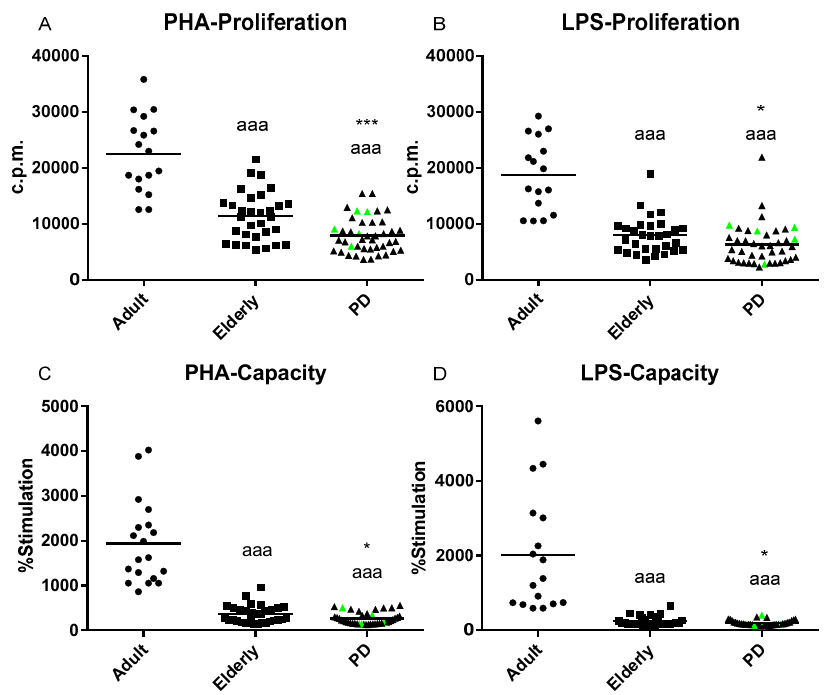
Figure 2. Stimulation of proliferation in response to phytohemagglutinin (PHA) and lipopolysaccharide (LPS) (1 μ g/mL) in isolated peripheral blood mononuclear cells of Parkinson´s Disease (PD) stage 2 patients, as well as of adult and elderly healthy controls. Lymphoproliferation (48 h incubation) in counts per minute (c.p.m.) with the mitogens ( A ) PHA and ( B ) LPS. Lymphoproliferation capacity (%) in response to ( C ) PHA and ( D ) LPS providing 100% to the c.p.m. in basal conditions. Data are shown as the mean (horizontal bar) of 16–45 values corresponding to the number of subjects analyzed in each group (20 adults, 34 elderly, and 45 PD). Each point represents the mean of duplicate assays. The green points represent the values in five PD patients treated with levodopa. aaa: p < 0.001 with respect to the value in adult subjects; * p < 0.05 and *** p < 0.001 with respect to the value in elderly subjects.